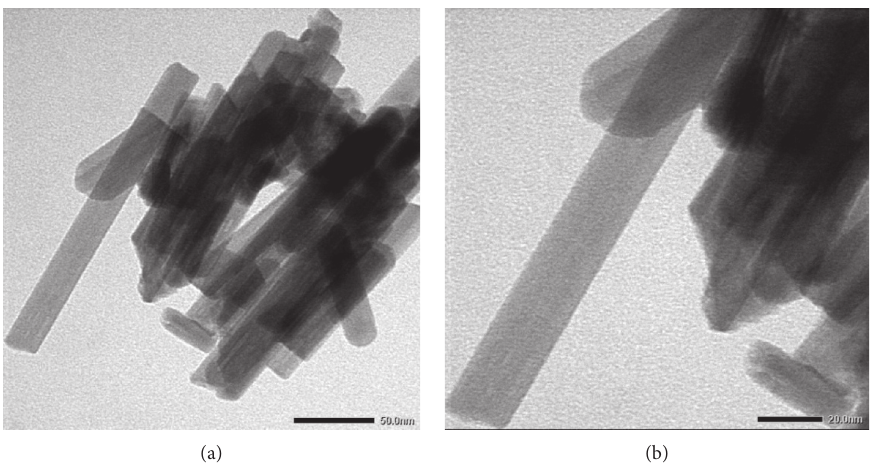
Figure 1: TEM images of CuFeO x /OMS-2 material at low and high